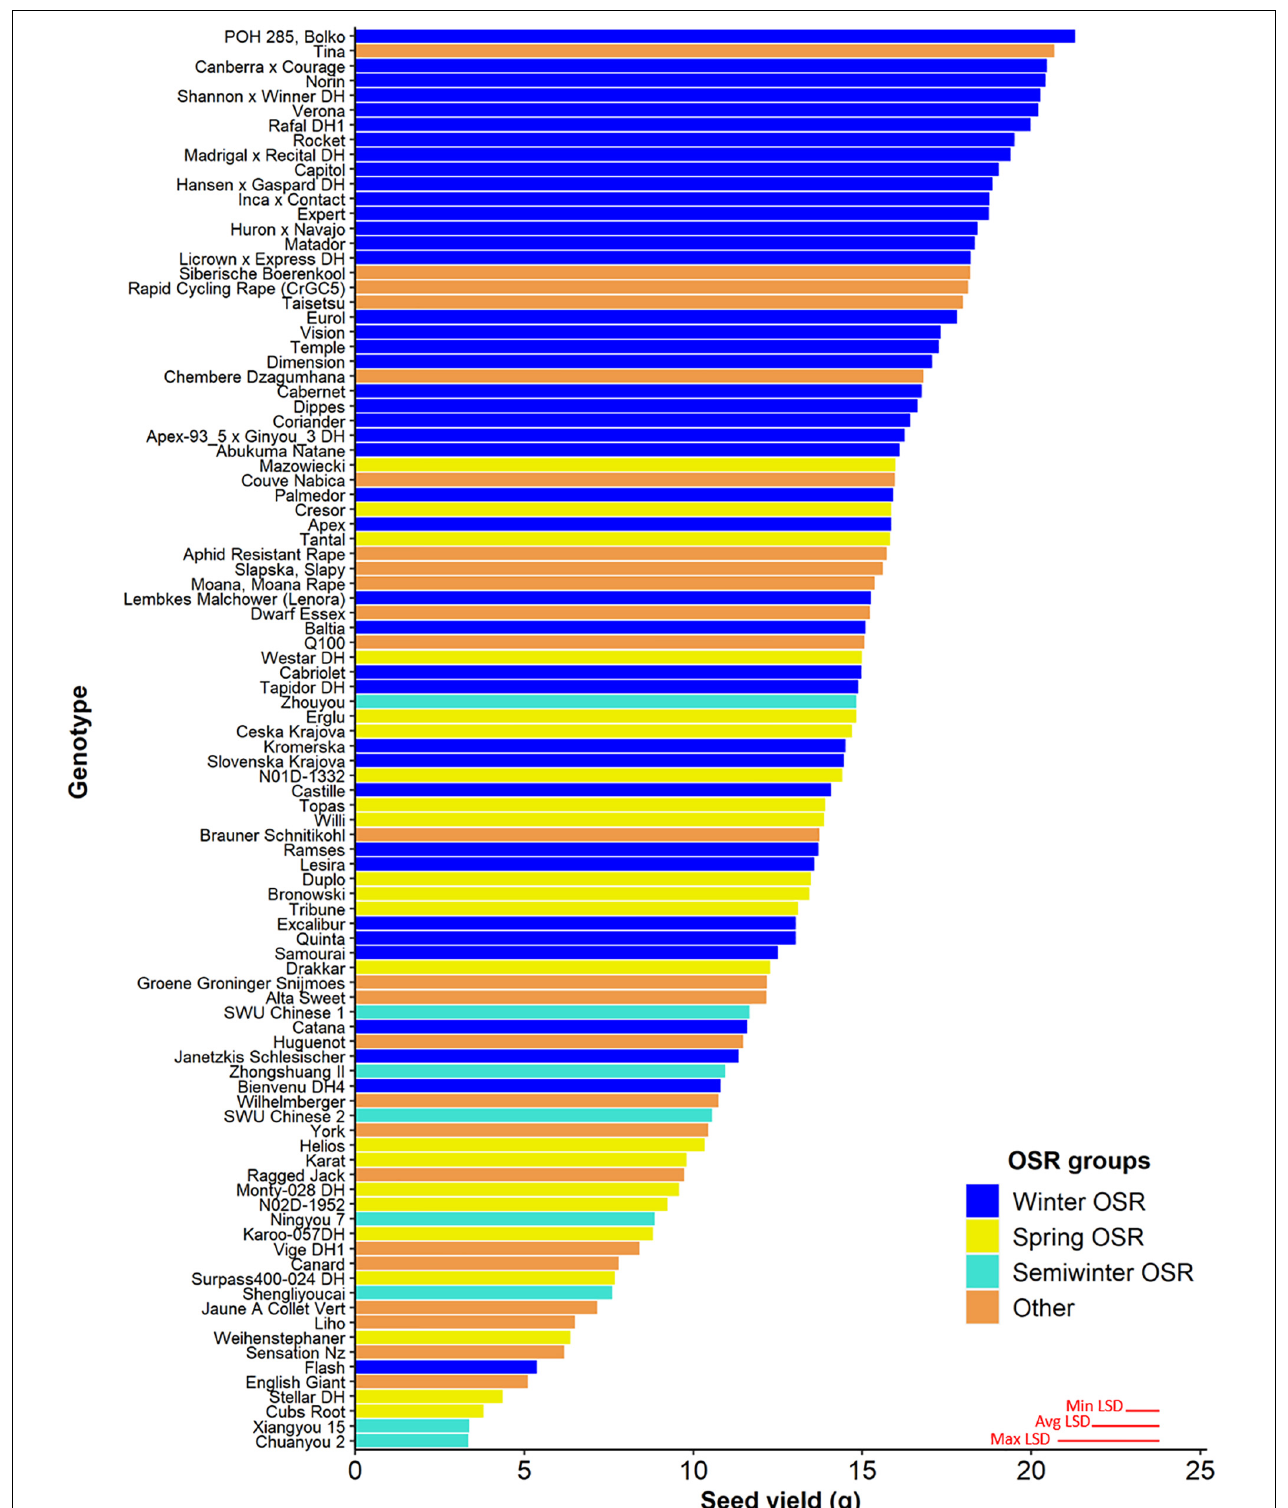
FIGURE 1 | Seed yield (g) for the 96 genotypes of the Brassica napus diversity set population for the 4 OSR groups (Winter OSR, Spring OSR, Semiwinter OSR, and Other). Data are the mean of five biological replicates. Maximum, average, and minimum least significant difference (max LSD, avg LSD, and min LSD, respectively) are represented as red lines in the bottom right corner of the